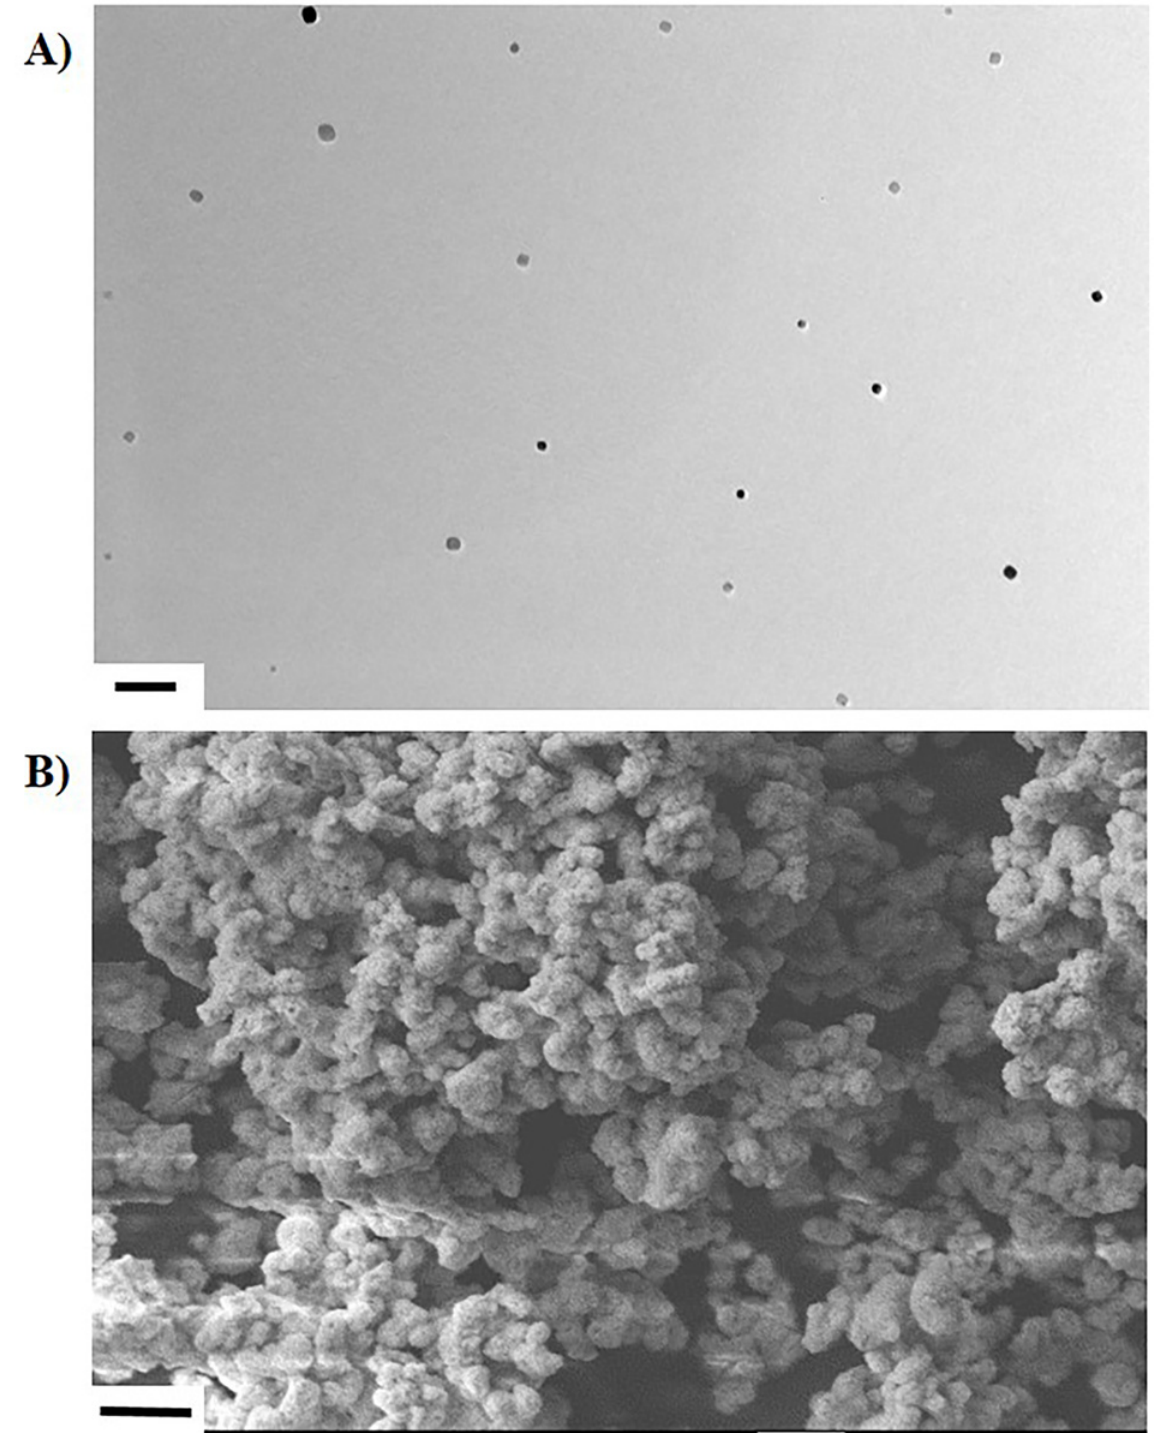
Fig 1. Characterization of WC-Co NP via A) TEM (scale bar = 500 nm) and B) SEM (scale bar = 1 μ m).